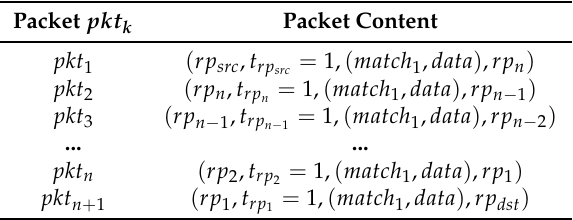
Table 2. Packets interleaving with update messages that correspond to match 1 .